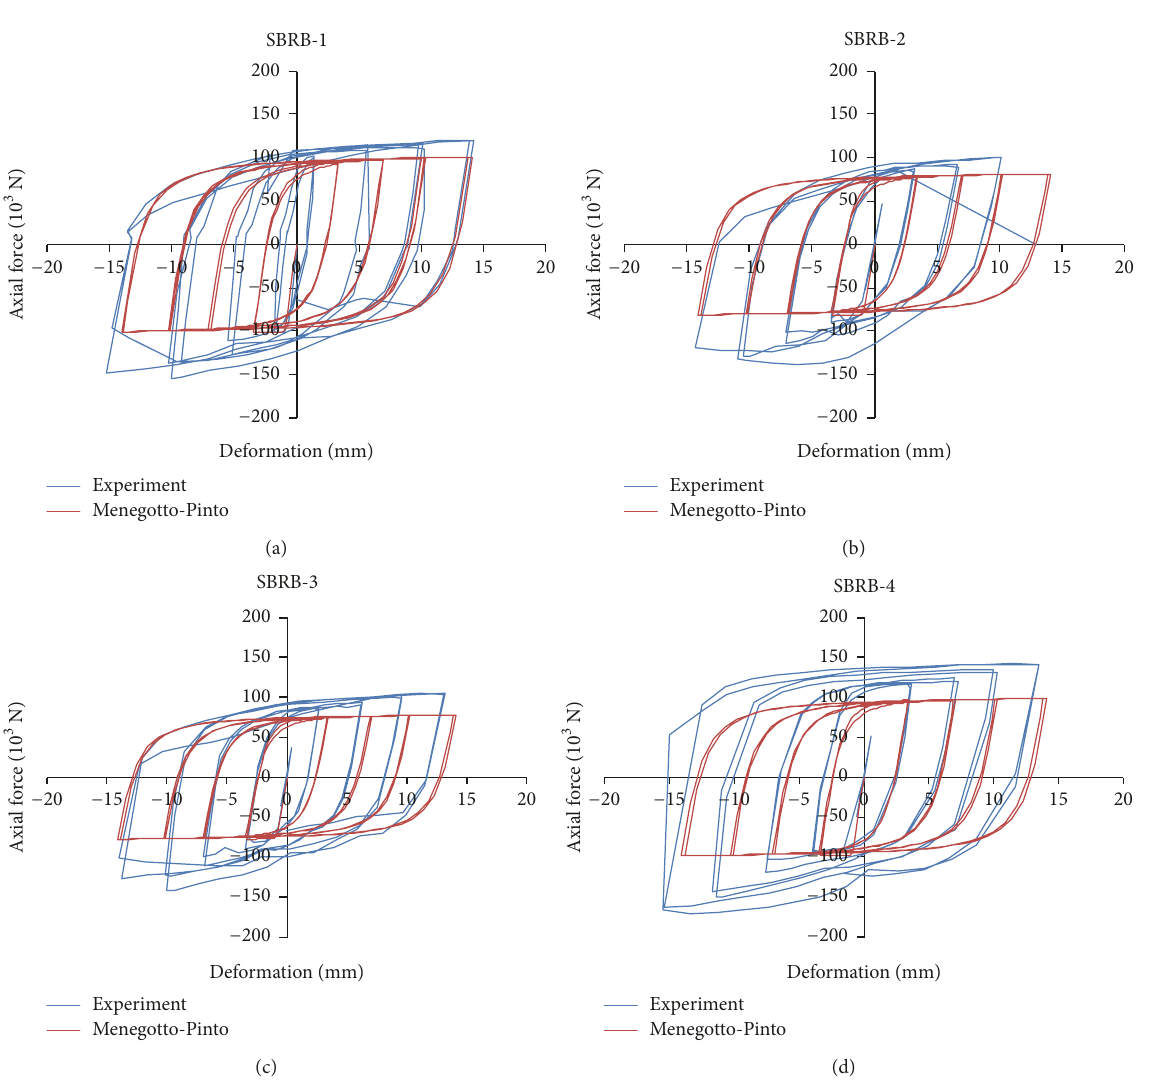
Figure 11: Hysteretic curves of SBRBs: experimental results by Sugihardjo [7] and analytical results using the Menegotto-Pinto functions [12] with steel core plates of (a) 50 × 8 mm; (b) 40 × 8mm; (c) 40 × 8 mm; (d) 50 × 8mm. Table 3: Hysteretic energy and cumulative ductility factor ( 𝜂 ) of